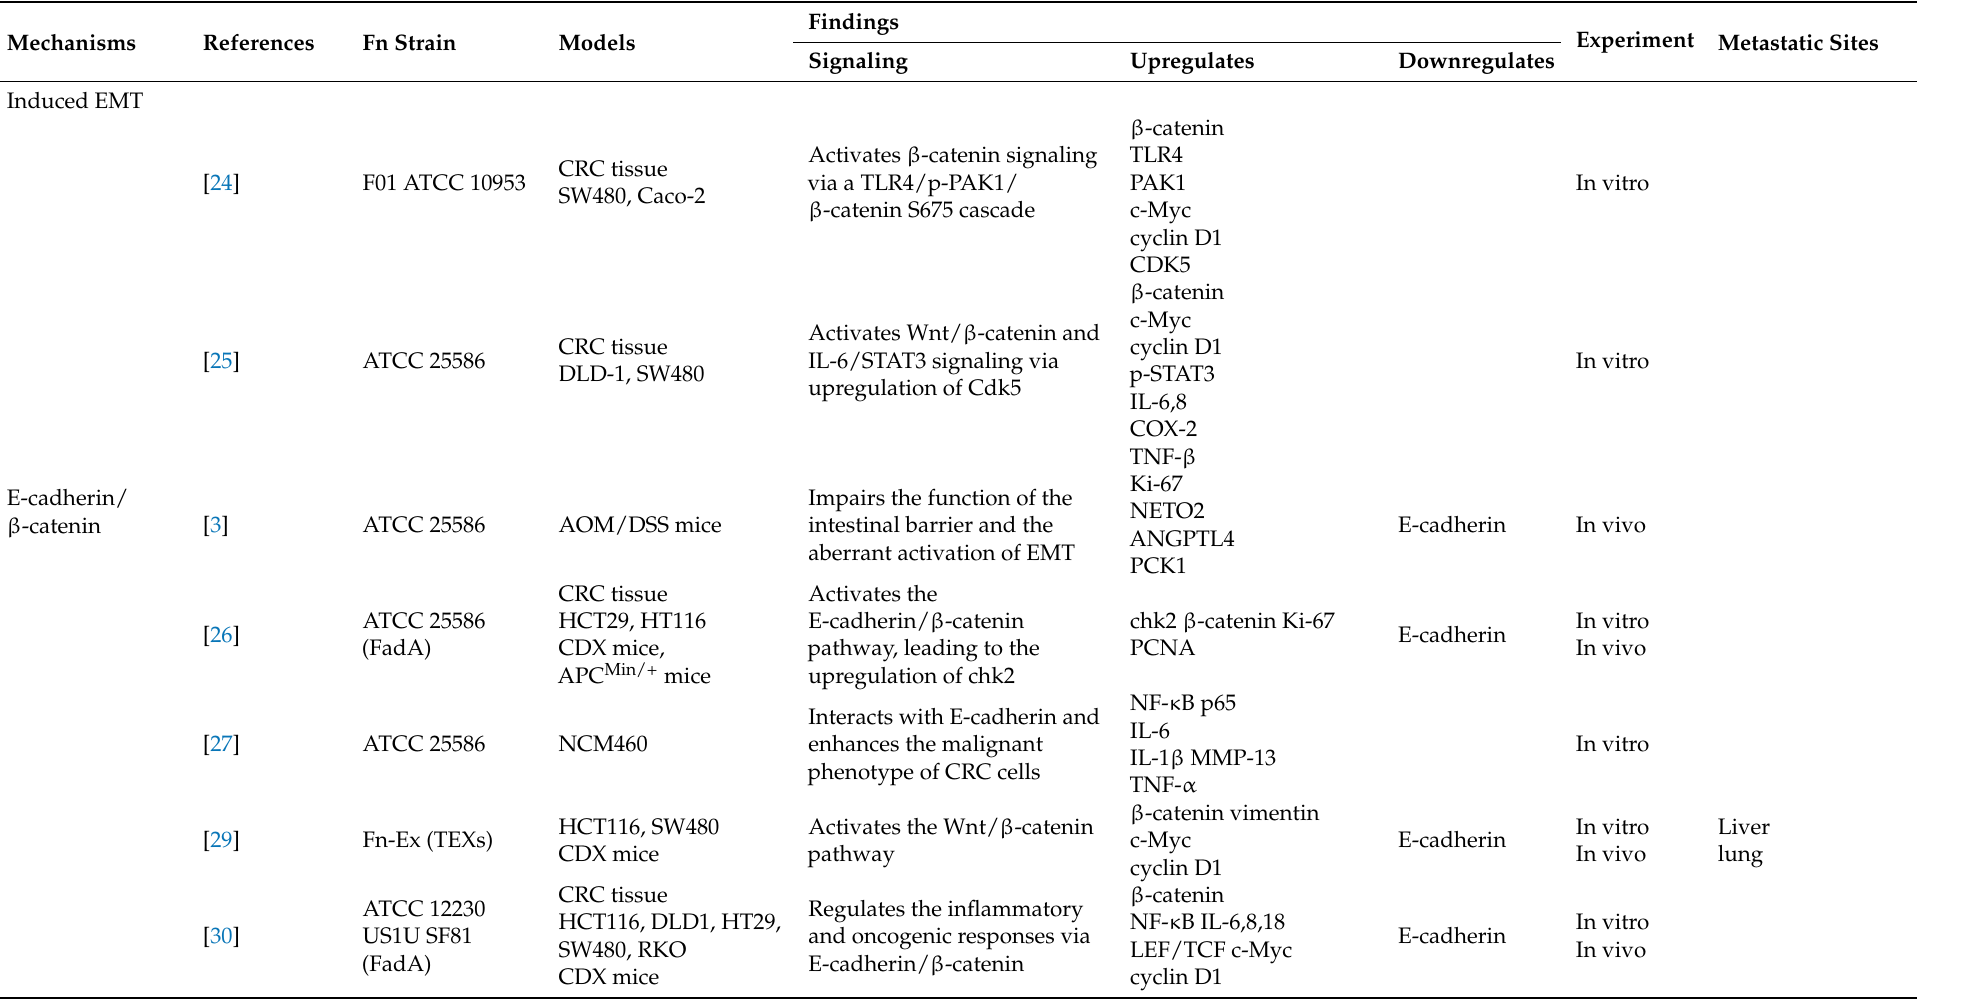
Table 2. Potential mechanisms of Fusobacterium nucleatum in CRC